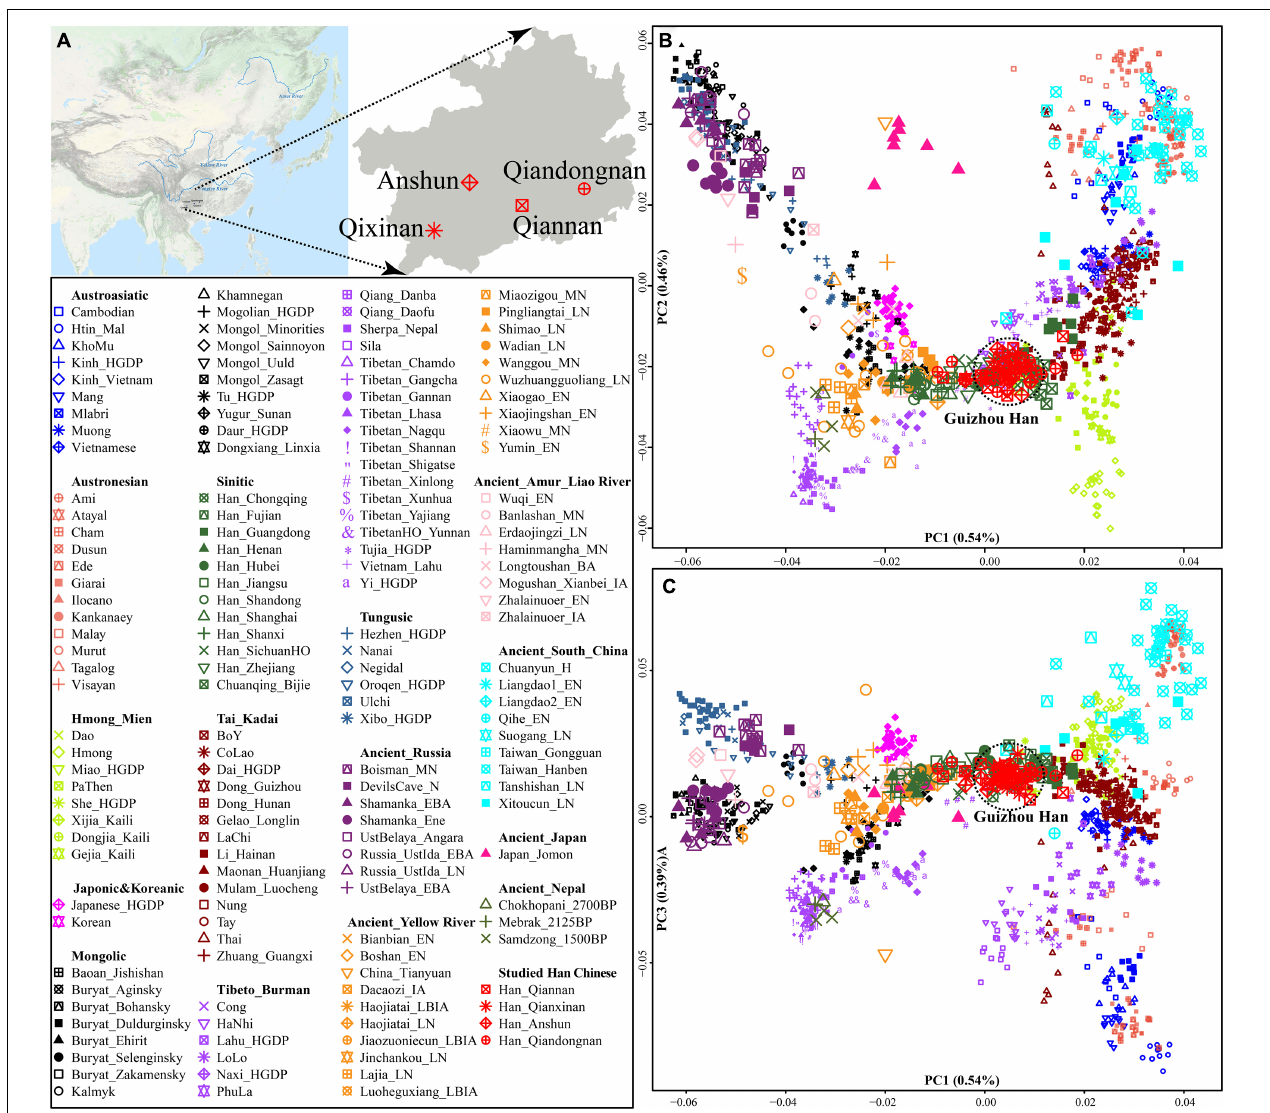
FIGURE 1 | General information of Guizhou Hans. (A) The geographic positions of four studied Guizhou Hans in southwestern China. (B,C) Principal component analysis based on the top three components among 1,220 modern and ancient East Asians from Altaic, Sino-Tibetan, Austronesian, Austroasiatic, Hmong-Mien, and Tai-Kadai people and other ancient eastern Eurasians (which were projected onto the basic background). Populations were shaped according to their unique ID from one language family. Different populations from one language families or groups were